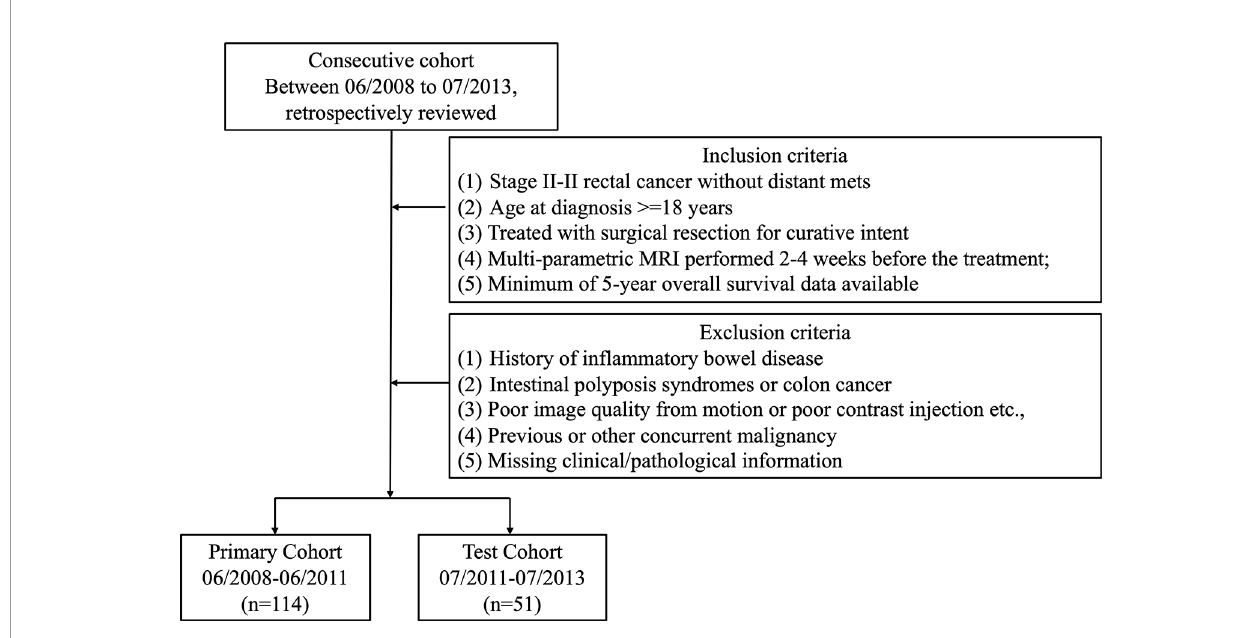
FIGURE 1 | A fl owchart showing patient